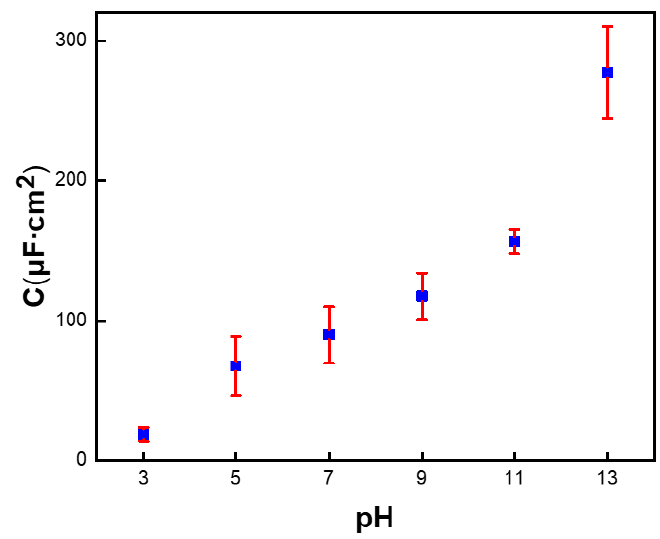
Figure 5. Capacitance as a function of pH for hydrogel-functionalized electrodes. The real-time response of I DS is shown in Figure 6, in which the drain current markedly increases when dropping a liquid solution on the gate. When the pH value of the buffer changes from acidic to basic, the time change rate curve changes regularly. The results are consistent with the transfer curve of the p-type silicon nanowire sensor increasing. The rate of change of different buffer pH curves is extracted from the time curve, and its distribution is shown in Figure 6b,d. For the SiNW FET, the rate of change ranges from 168 to 396, which is linear with pH correlation. While the rate of change ranges from 179 to 14,520 for hydrogel-modified SiNW FET devices, it is exponentially related to the value of buffer pH. Therefore, when the ion concentration of the liquid to be tested is constant, the change in pH for the hydrogel-modified SiNW FET sensors is more sensitive.